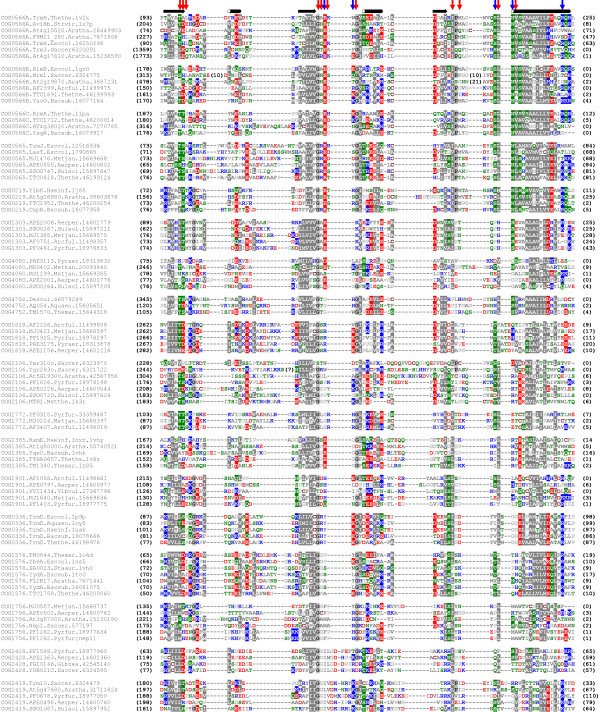
Multiple sequence alignment of selected representatives of SPOUT COGs. Sequences are denoted by the COG number, species' name, the NCBI gene identification (GI) number and the PDB code (if applicable). The variable termini and non-conserved insertions are not shown; the number of omitted residues is indicated in parentheses. Amino acids are colored according to the physico-chemical properties of their side-chains (negatively charged: red, positively charged: blue, polar: green, hydrophobic: grey). The consensus secondary structure is shown above the alignment as tubes (helices) and arrows (strands). The most typical positions of AdoMet-binding residues are indicated above the alignment by vertical red arrows, while the typical positions of catalytic residues are indicated by blue arrows. Note that additional catalytic residues may be present in the N-terminal part (unalignable and therefore not shown in this figure) and that the position of catalytic residues varies between families, e.g. it depends on the mode of dimerization.